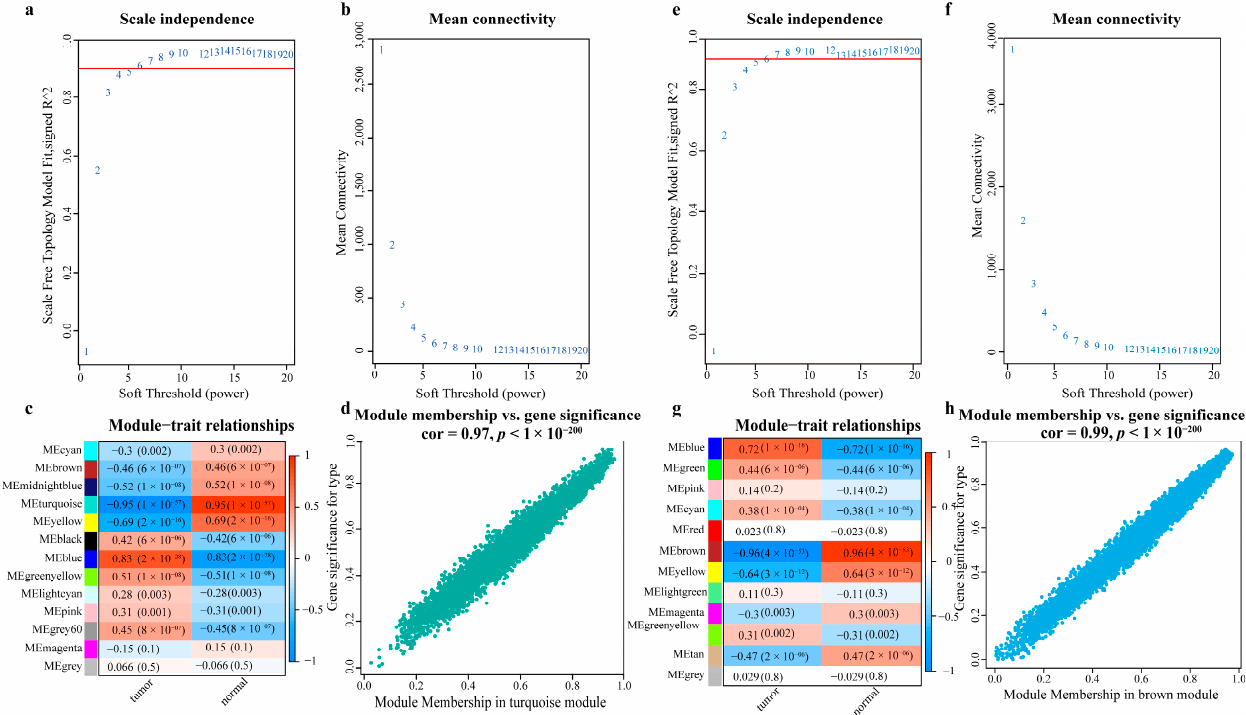
Figure 3. Identification of LUAD/LUSC-related gene set based on WGCNA. ( a , e ) are the scale-free fit indices of various soft-thresholding powers, both with the best soft-thresholding value of 7. ( b , f ) The average connectivity of various soft-thresholding powers, and the y-axis is a decreasing function of the soft-thresholding power β (x-axis). ( c , g ) The gene modules associated with the clinical features of LUAD/LUSC. Each module contains the corresponding correlation and p -value, and the correlation coefficient represents the correlation between the gene modules and the clinical features; the color shade represents the correlation size, red indicates a positive correlation, and blue indicates a negative correlation. ( d , h ) Scatter plots of the clinical trait between module membership (x-axis) and gene significance (y-axis) in the Turquoise module. Module membership (x-axis) refers to the correlation between the genes and the module, with larger values indicating the greater correlation between the genes and the module, and gene significance refers to the correlation between the genes and the trait, with larger values indicating the stronger correlation between the genes and the trait (LUAD: r = 0.97, p < 1 × 10 − 200 ; LUSC: r = 0.99, p < 1 × 10 − 200